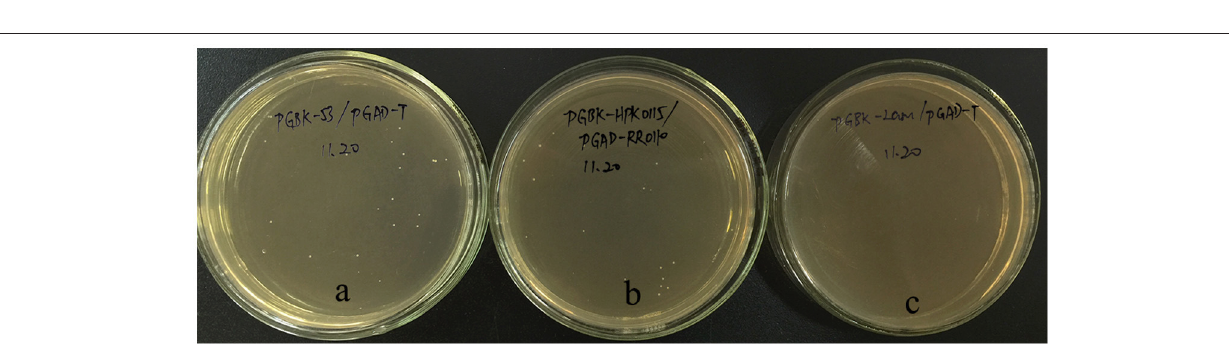
Frontiers in Microbiology |